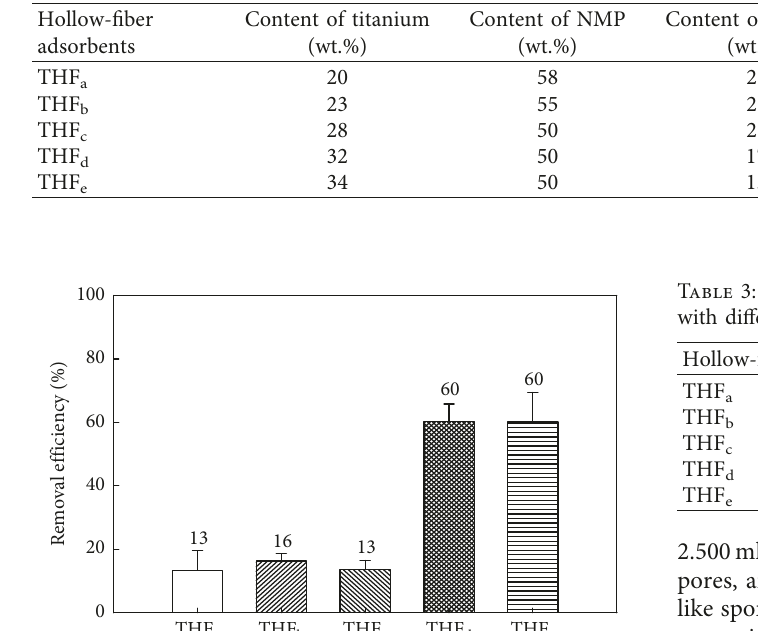
Table 2: Contents and specific surface areas of hollow-fiber adsorbents with different compositions.